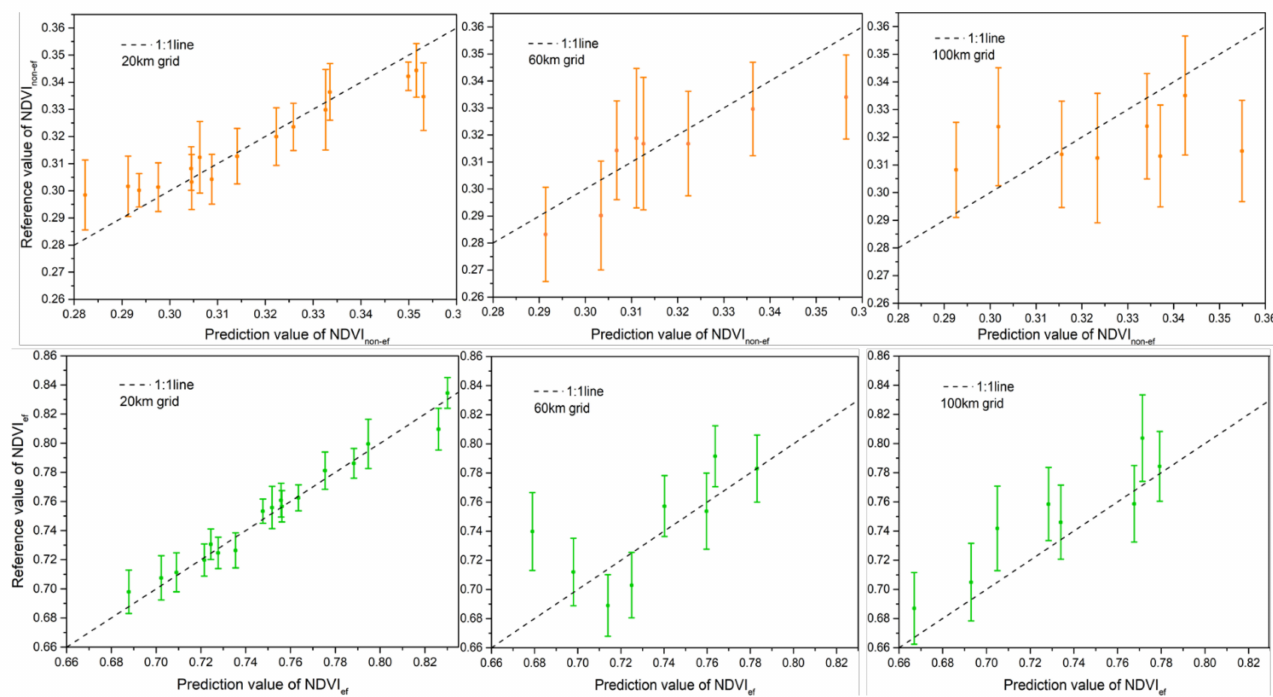
Figure 6. Parameter simulation accuracy by grid size. Red line represents the error between reference value and prediction value of NDVInon-ef, Green line represents the error between reference value and prediction value of